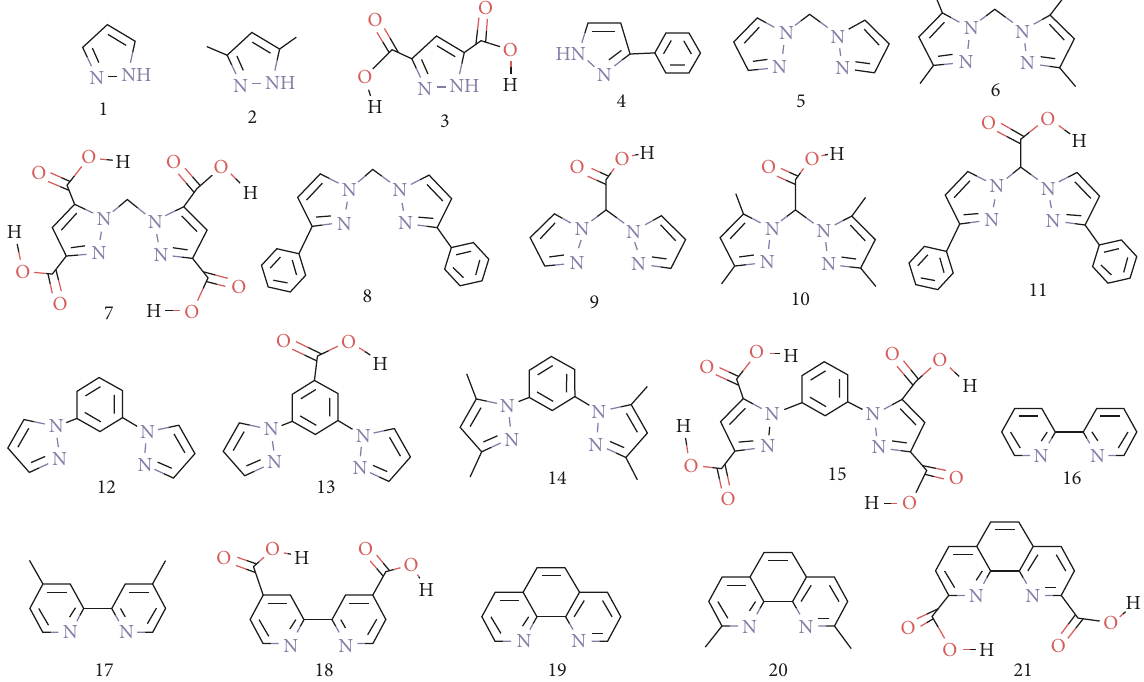
Figure 1: The schematic representation of the studied nitrogen-chelating